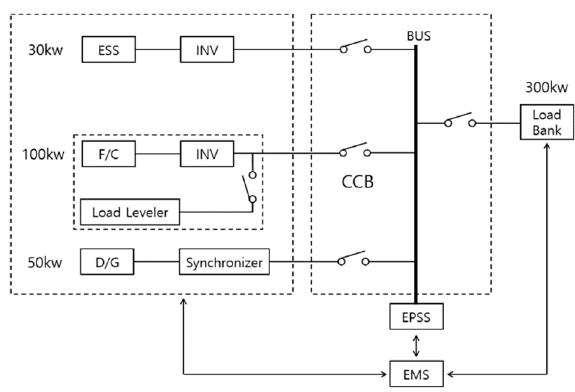
Figure 2. Basic outline of hybrid power systems for the test bed.